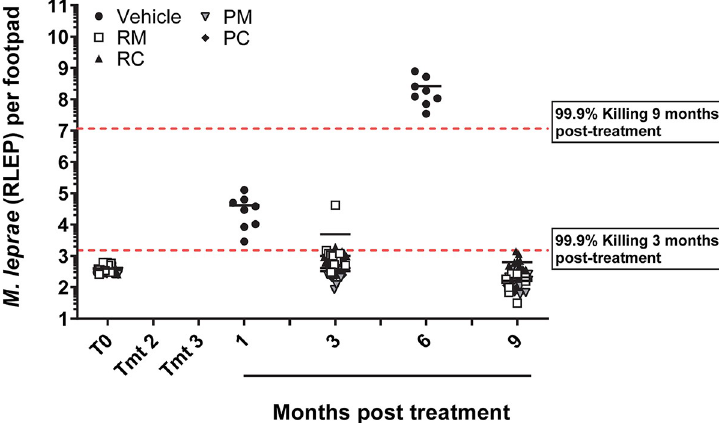
Fig 3. Multi-dose PEP regimens control bacterial growth. Athymic nude mice were infected in both hind footpads with 6 x10 3 M . leprae . Mice were treated with three once-monthly doses of rifampin/moxifloxacin (RM), rifampin/ clarithromycin (RC), rifapentine/moxifloxacin (PM), or rifapentine/clarithromycin (PC). M . leprae were enumerated one, three, six, and nine months post treatment completion. Bars represent the mean for each group. A regression analysis was calculated to determine the expected RLEP value if 99.9% of the bacilli were killed after the administration of the three dose regimen (r 2 = 0.998). The 99.9% kill line at 3 months was 1.51 x 10 3 bacilli, and the 99.9% kill line at 9 months was 1.16 x 10 7